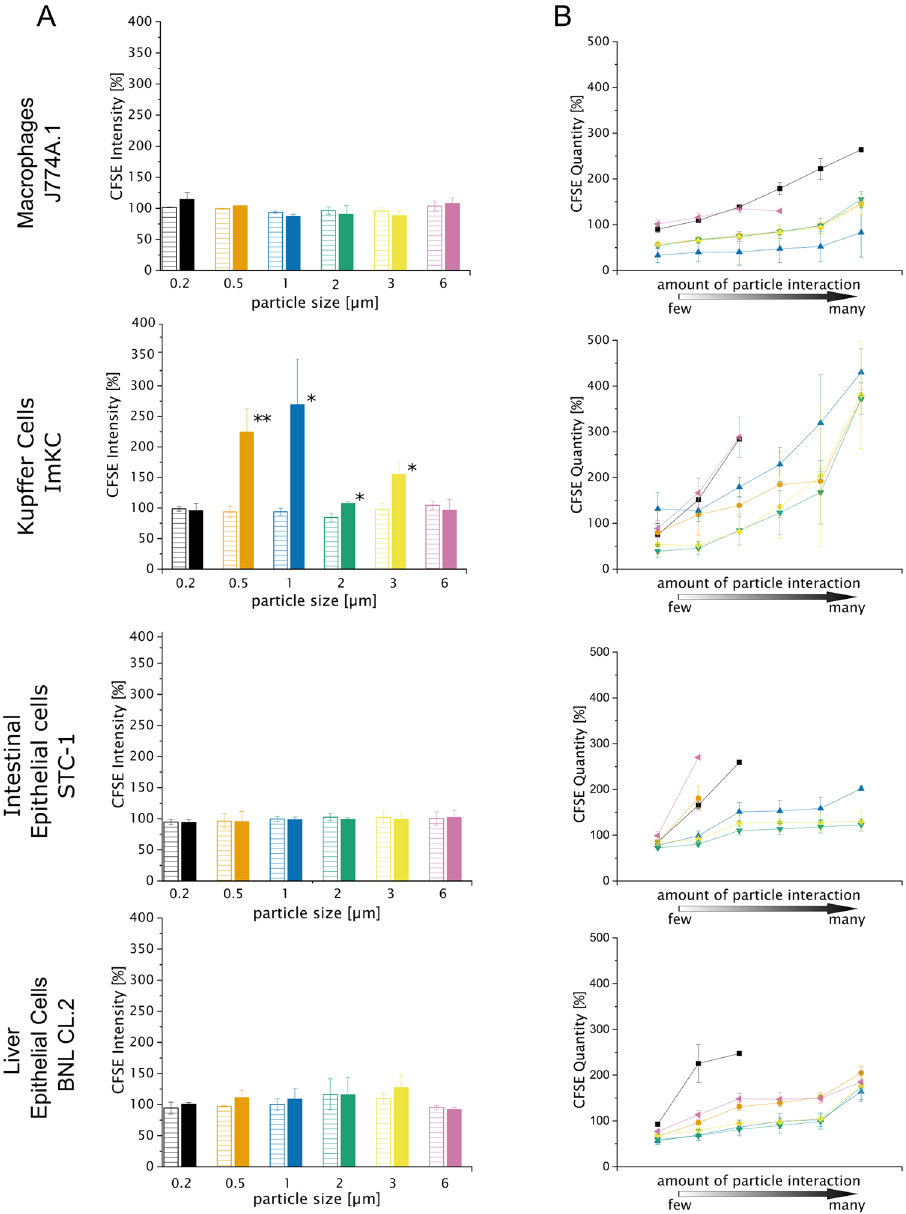
Figure 6. CFSE dilution assay after 72 h. CFSE assay was performed in presence of all particle sizes using all cell lines. Values were normalized (control: cells incubated without particles). As the CFSE intensity per cell is decreasing with every division, higher values for “CFSE intensity” indicate a reduced number of cell division. ( A ) Shows an analysis of the entire population while ( B ) adapts the same gating strategy for subpopulations as in Fig. 4A. Low MPP concentration: striped bars, high MPP concentration: filled bars. Black square = 0.2 µm, orange circle = 0.5 µm, blue triangle = 1 µm, green down-pointed triangle = 2 µm, yellow diamond = 3 µm, purple left-pointed triangle = 6 µm). Data represent mean ± SD, n = 3 biological replicates, *p < 0.05, **p < 0.01 compared to